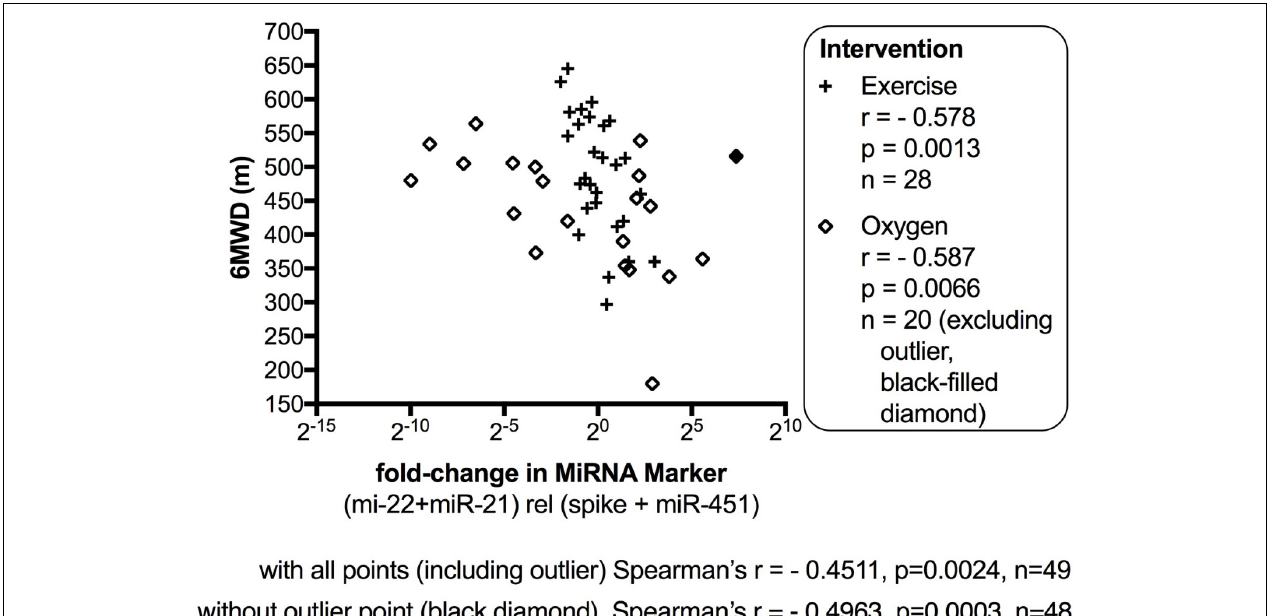
FIGURE 6 | Correlation between change in miRNA marker and 6-min-walking-distance, supervised exercise training and nightly oxygen intervention data combined. The fold-change in miR-22-3p + miR-21-5p relative to spike-RNA + miR-451a (10,000 × ) values (after/before exercise, or oxygen/placebo, respectively) were plotted against 6-min walking distance (m) measured at baseline examination from the patients. The data from the exercise training intervention study were plotted with × symbols, and the data from the nightly oxygen intervention study were plotted as clear/black-filled diamond symbols. The black-filled diamond represents one outlier data point, and correlations were calculated with and without the outlier point as indicated. The correlation was calculated with Spearman’s rank correlation test; p < 0.05 was considered significant. For this analysis, samples from three patients who had a body mass index (BMI) greater that 40 kg/m 2 and who achieved 6-min-walking-distances between 150 and 190 m were